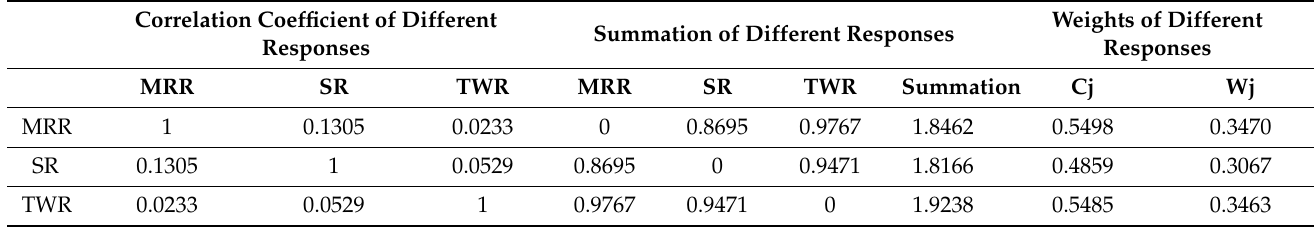
Table 13. Correlation coefficient, summation, and weights of different responses.